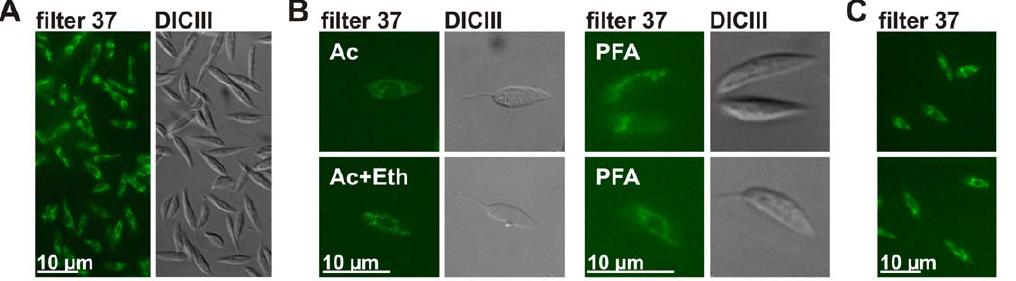
Figure 1. Detection of autofluorescent subcellular structures in L.tarentolae promastigotes. Parasites were analyzed by fluorescence microscopy without labeling or staining procedures. (A) Overview of PFA-fixed L. tarentolae promastigotes. (B) The following agents were used for alternative fixation protocols: Ac, acetone; Ac + Eth, acetone and ethanol; PFA, PFA in PBS. (C) Live cell images of washed L. tarentolae promastigotes without cell fixation. Slides were analyzed with a Zeiss Axiovert 200 M microscope and the software Axiovision. The autofluorescence was detected with the Zeiss filter set 37 (filter 37). Cells were visualized by differential interference contrast (DICIII). A XBO lamp served as a light source.